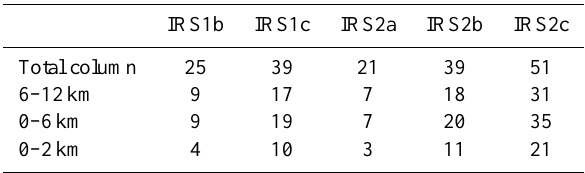
Table 8. Improvement in terms of errors expressed in relative gain (%) from the IRS1a-IASI scenario for different atmospheric layers: O 3 total column, 6–12km column, 0–6km column and 0–2km col- umn.